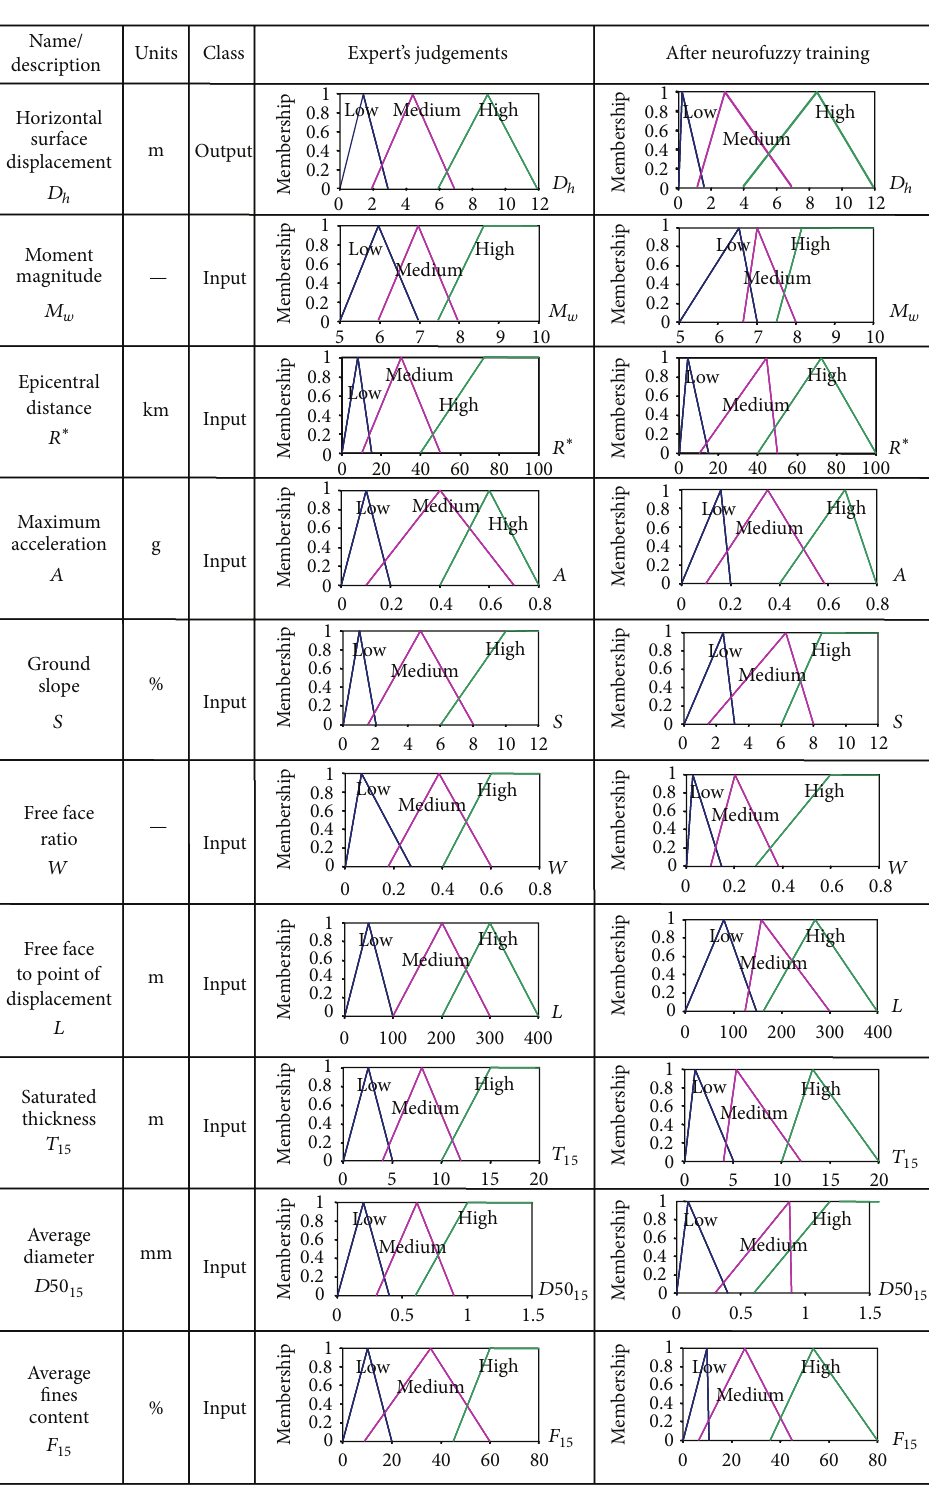
Figure 31: Membership functions used as neurofuzzy system